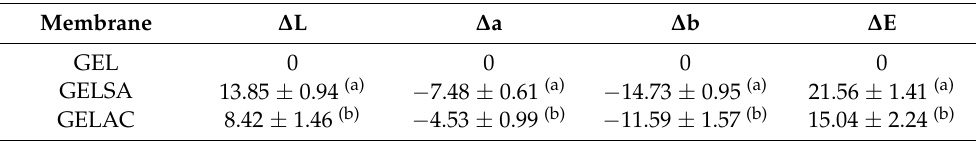
Table 3. Mean values of the color parameters obtained in the colorimetric analysis on a white background of the GEL, GELSA, and GELAC biomembranes. Different letters in the same column represent statistically different values. p < 0.001.